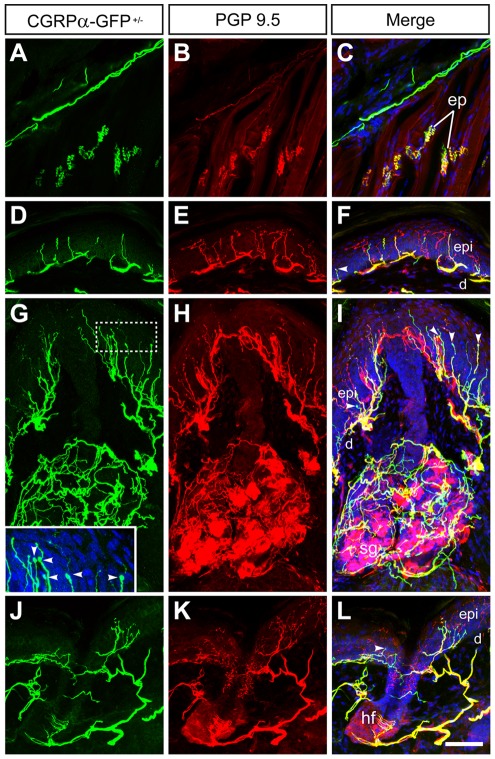
CGRP?-GFP+ axons innervate muscle and skin.Sections of hindpaw from CGRPα-GFP+/? mice were stained with antibodies to (A,D,G,J) GFP and (B,E,H,K) the pan-nerve fiber marker PGP9.5. (C,F,I,L,G-inset) Merged images were stained with the nuclear marker DRAQ5 to visualize skin cells. (AC) Nerve bundle in the subdermis and motor end plates (ep). (DF) Epidermis (epi) and upper dermis (d) from glabrous skin, (GI) sweat gland (sg) in glabrous skin and (JL) guard hair follicle (hf) in hairy skin. Arrowheads point to putative transduction spheres. Images were acquired by confocal microscopy and are representative of n = 3 mice. Scale bar in (L) is 100 μm.